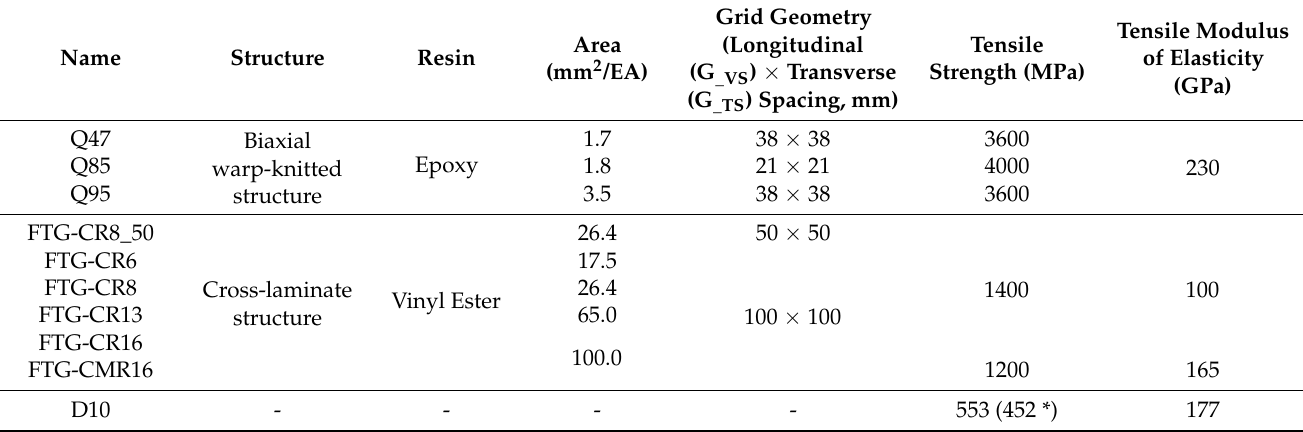
Table 2. Characteristics of the carbon grids and tensile